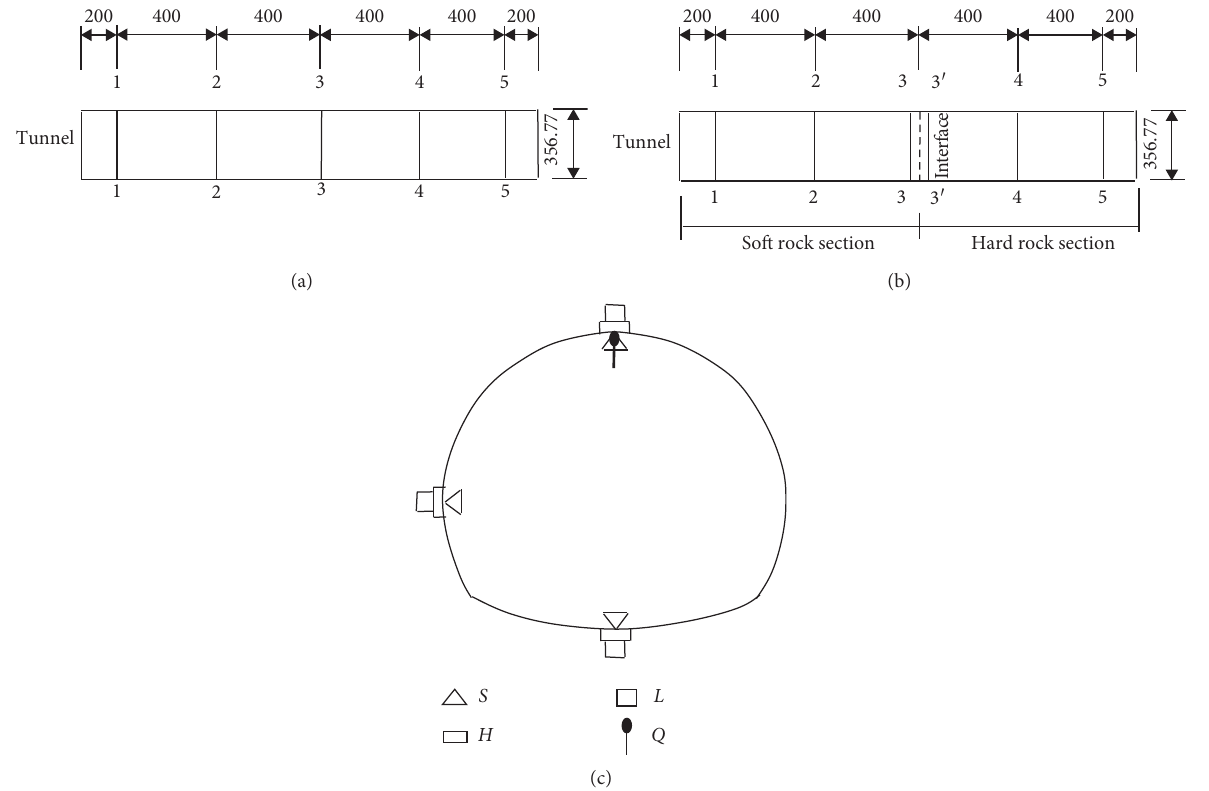
Figure 8: Layout of monitoring sections and points (unit: mm). (a) Monitoring sections of homogeneous soft rock or hard rock. (b) Monitoring sections of interface of soft and hard rock. (c) Monitoring